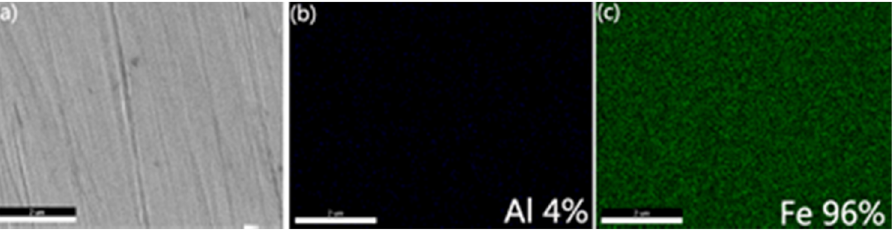
Figure 2: EDS spectrum of wrench section. ( a ) SEM image of wrench cross section, ( b ) Al 4%, and ( c ) Fe